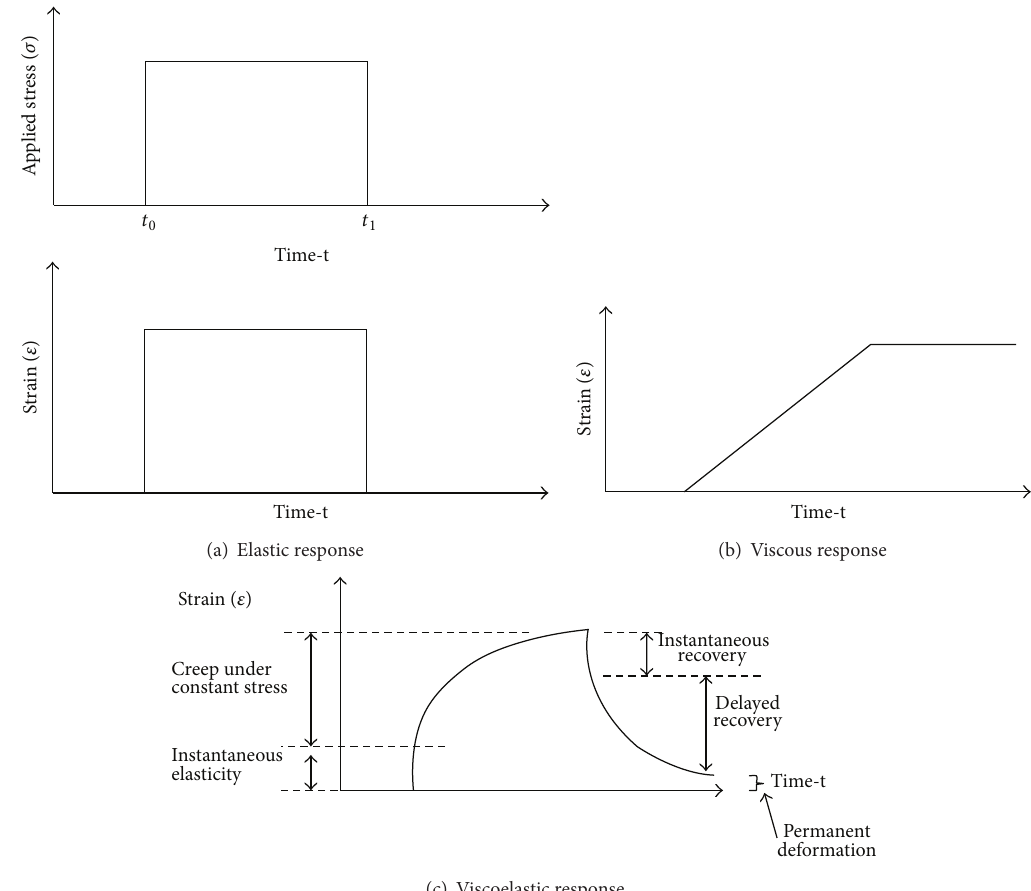
Figure 10: General behaviour of elastic, viscous, and viscoelastic material under constant stress loading [75].